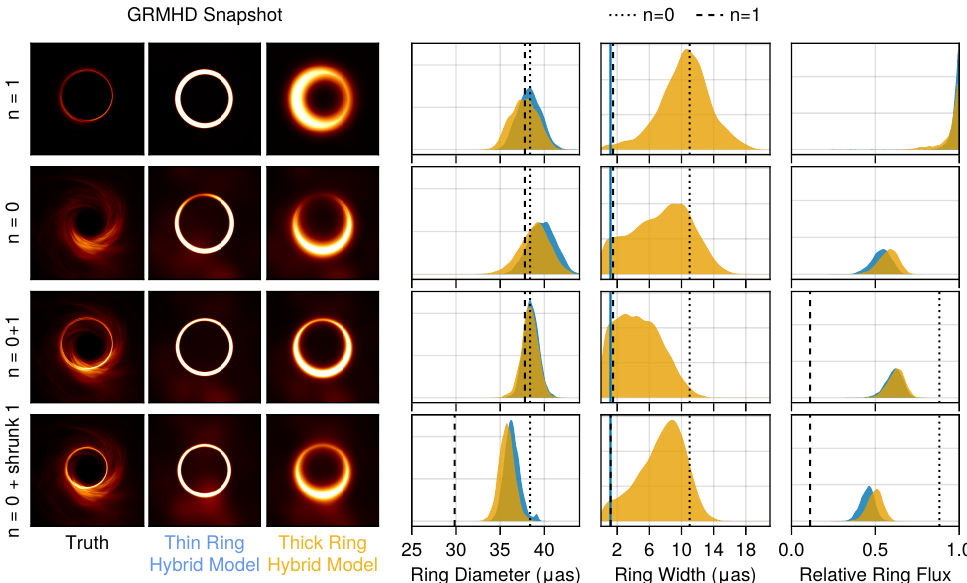
Figure 4. Results of fitting a GRMHD simulation snapshot with coverage corresponding to the EHT 2017 array. The GRMHD simulation has a spin of 0.9375, inclination of 163 ◦ , r high = 10, and is in the MAD accretion state. The top row shows the results from fitting only the n = 1 emission with the hybrid model, the second row shows fits to only the n = 0 emission, and the third row shows fits to the combined n = 0 + 1 emission. The bottom row shows fits to the combined n = 0 + 1 emission after reducing the diameter of the n = 1 ring by 21%. All rows show both fits that force the ring component to be thin (blue) and fits that do not constrain the ring width (orange). The black dashed lines show true values for the n = 1 photon ring, while the black dotted lines show the true values for the n = 0 photon